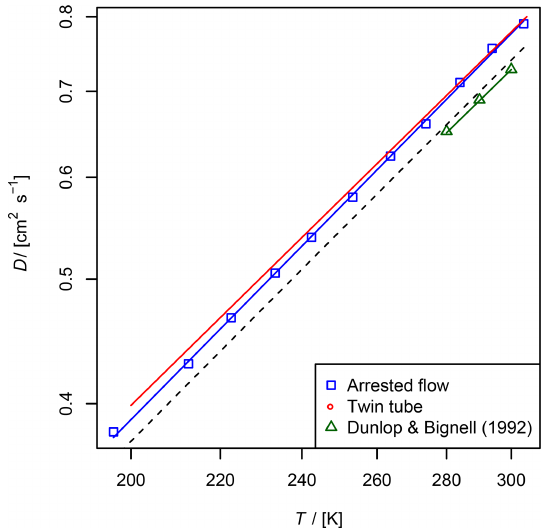
Figure 8. Diffusion coefficient of NO in He measured by the AF and TT method as a function of temperature. For the TT method only the fit function is shown. Experimental results from Dunlop and Bignell (1992) and a fit to Eq. (5) with D 0 = 0 . 624 and b = 1 . 64 are displayed as a reference. The dashed line is calculated using the Lennard–Jones model.